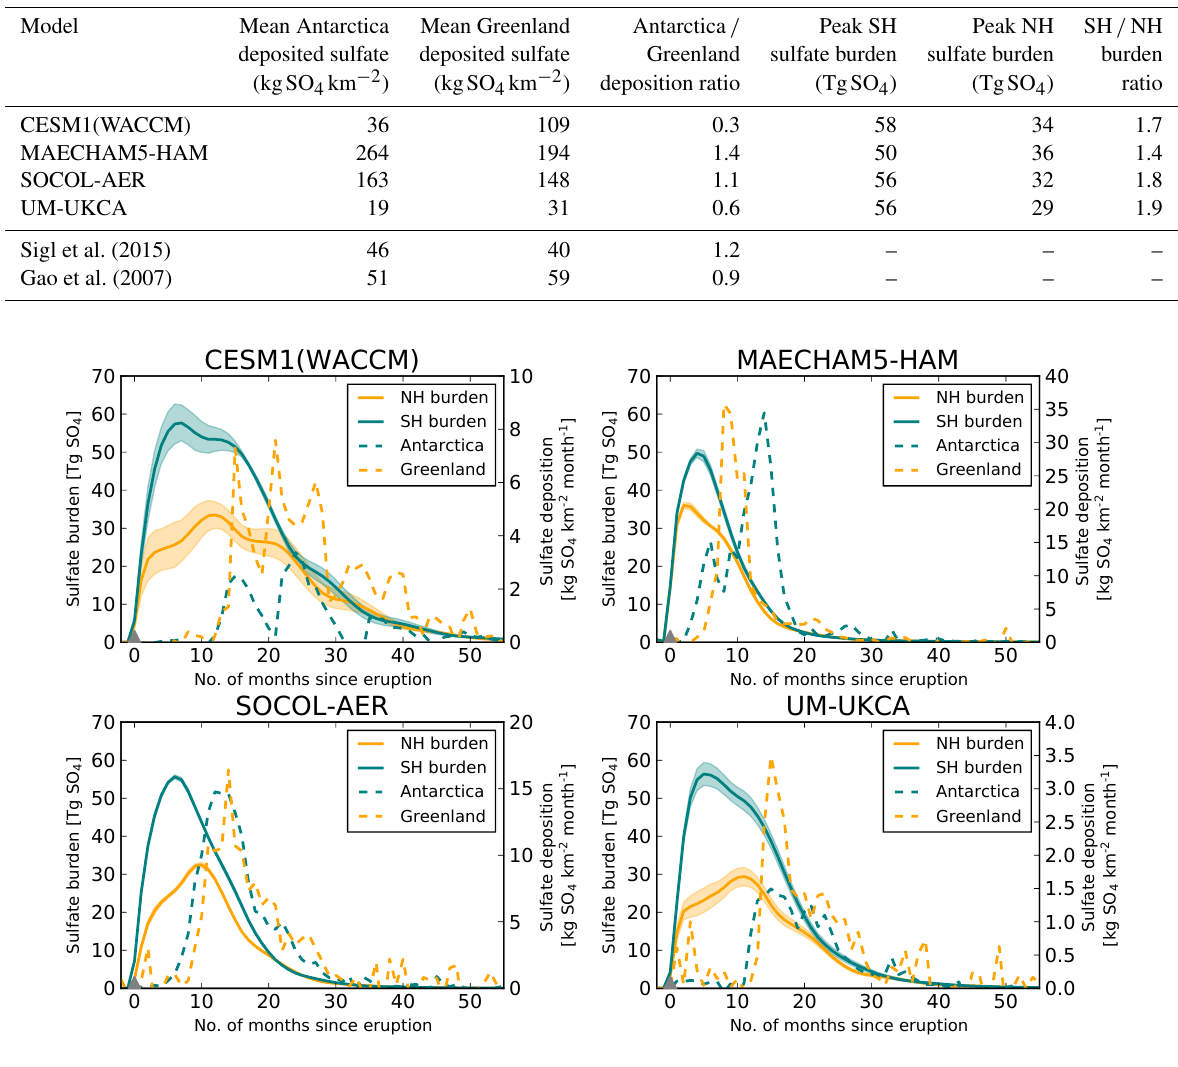
Table 5. Greenland and Antarctica ice sheet mean cumulative deposited sulfate and ratio (Antarctica deposition / Greenland deposition) and peak NH and SH sulfate burdens (total atmospheric column burden anomaly) and ratio (SH burden / NH burden) for each model (ensemble mean). Also included is the equivalent mean deposited sulfate on each ice sheet calculated from ice cores (Gao et al., 2007; Sigl et al., 2015).